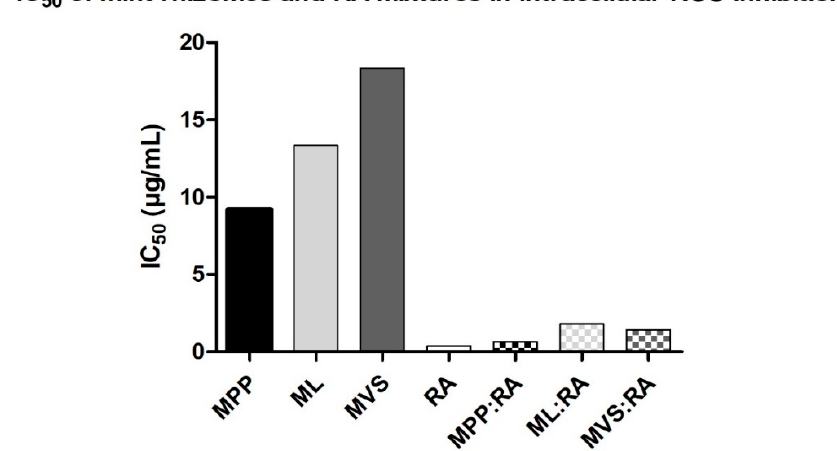
Figure 2. IC 50 ( µ g / mL) of Mentha rhizomes extracts (MPP— Mentha × piperita cv. ‘Perpeta’, ML—